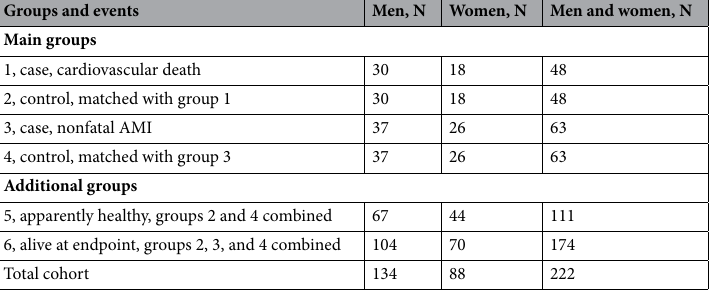
associations by comparing group 1 versus group 6 and group 3 versus group 5. The workflow of analysis is shown in Fig. 1. Univariate associations of biomarkers with cardiovascular deaths. All 15 biomarkers (routine and experimental) were assayed in the samples of all participants, and the results are presented in Supplemental Table S2, which also lists the corresponding reference values for routine biomarkers for moderate cardiovascular risks 19 . However, experimental biomarkers do not have certified and validated reference values. All biochemical parameters were divided into terciles. Associations of the upper tercile (higher 33% values above the cutoff are shown in Supplemental Table S3) with cardiovascular death and nonfatal AMI endpoints were compared with those for the two lower terciles combined. Initially, comparison was performed using uni- variate logistic regression for group 1 versus group 2, group 1 versus group 5, group 1 versus group 6, group 3 versus group 4, and group 3 versus group 5 (Fig. 1, Supplemental Tables S4 and S5). The results of this univariate logistic analysis indicated that six biomarkers were associated with cardiovas- cular deaths, including 5 biomarkers associated with an increase in mortality (cTnI, galectin-3, NOx, CRP, and creatinine) and HDL cholesterol associated with a decrease in mortality. The levels of cTnI selected as a reference were clearly associated with mortality regardless of sex, and the associations remained significant in all three tested comparisons (Supplemental Table S4). Galectin-3, CRP, and HDL cholesterol had significant associations with mortality in comparison of group 1 versus group 2 in men. Internal confirmation by comparison of group 1 with group 5 indicated that these 3 biomarkers (galectin-3, CRP, and HDL cholesterol) preserved their associations. Moreover, two additional associations were detected, including ANGPTL3 и NOx, which were not sex-dependent similar to cTnI and unlike CRP, creatinine, and HDL cholesterol. Higher levels of ANGPTL3 were associated with a decrease in mortality similar to associations detected for HDL cholesterol. Subsequent expansion of internal confirmation by comparison of group 1 versus group 6 indicated that NOx was no longer associated with mortality (Supplemental Table S4) apparently due to the impact of NOx associa- tions with nonfatal AMI (Supplemental Table S5). However, ANGPTL3 and cTnI maintained the associations regardless of sex, and CRP maintained the association in men. Creatinine lost its association (Supplemental Table S4) apparently due to normal glomerular filtration rate, which was within the reference range for all subjects. Univariate associations of biomarkers with nonfatal AMI. Table S5). Case–control comparison of group 3 versus group 4 indicated significant and sex-independent asso- ciations with NOx and associations with cTnI and insulin only in female subjects, although cTnI preserved the associations in the combined male and female subgroups. Internal confirmation of these associations by expanded comparison of group 3 versus group 5 confirmed sex-independent associations of nonfatal AMI with NOx and association with cTnI in the female subgroup. This expanded comparison revealed sex-dependent associations of endothelin-1, galectin-3, and ANGPTL3 with nonfatal AMI. Thus, the results of univariate analysis indicated that only elevated NOx was sex-independently associated with nonfatal AMI with an average odds ratio of approximately 3 (P < 0.03), and elevated ANGPTL3 was associ- ated with nonfatal AMI only in men (Supplemental Table S5). Elevated levels of cTnI, galectin-3, and insulin were associated with a higher risk of nonfatal AMI predominantly in women. Moreover, cTnI, galectin-3, ANGPTL3, and NOx were also sex-independently associated with cardiovascular death. Stepwise Cox regression analysis. Cox regression was used to expand the description of the associations of biomarkers by inclusion of the time variable. Stepwise analysis was used to select optimal models (Table 2). The results indicated that ANGPTL3, cTnI, PCSK9, endothelin, galectin-3, and CRP were associated with cardiovascular death, and ANGPTL3, cTnI, PCSK9, NOx, leptin, insulin, and total cholesterol were associated with nonfatal AMI. ANGPTL3, cTnI, and PCSK9 were not specific and did not discriminate between mortality